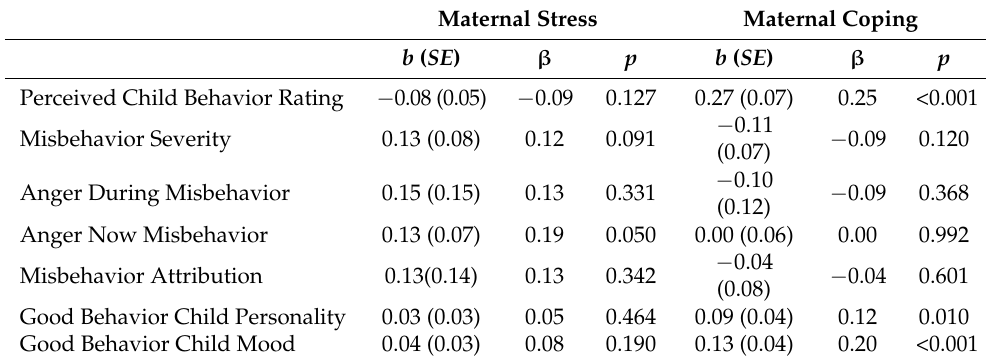
Table 3. Summary of within-person regression of child ratings on maternal stress and coping.